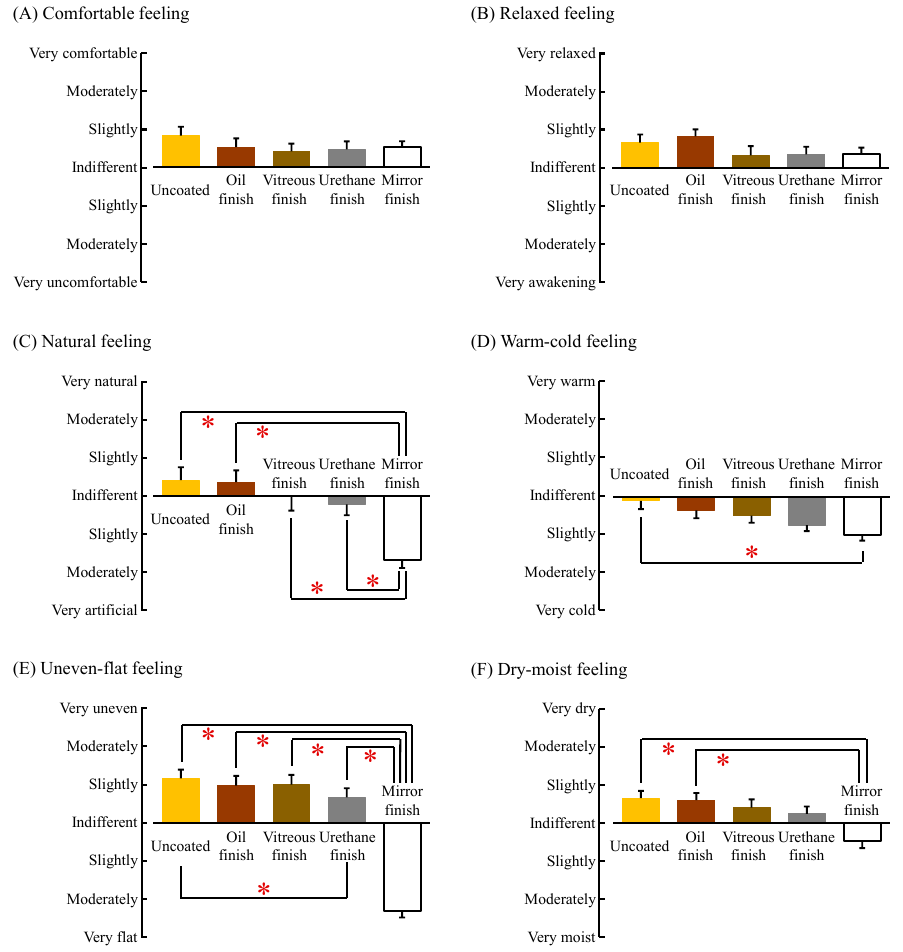
Figure 8. Subjective feelings measured by the modified SD method after touching white oak wood (uncoated, oil finish, vitreous finish, urethane finish, and mirror finish). ( A ) Comfortable feeling; ( B ) relaxed feeling; ( C ) natural feeling; ( D ) warm–cold feeling; ( E ) uneven–flat feeling; ( F ) dry–moist feeling. Data are expressed as mean ± standard error, n = 18, * p < 0.05 as determined by the Wilcoxon signed-rank test; Holm correction was applied.